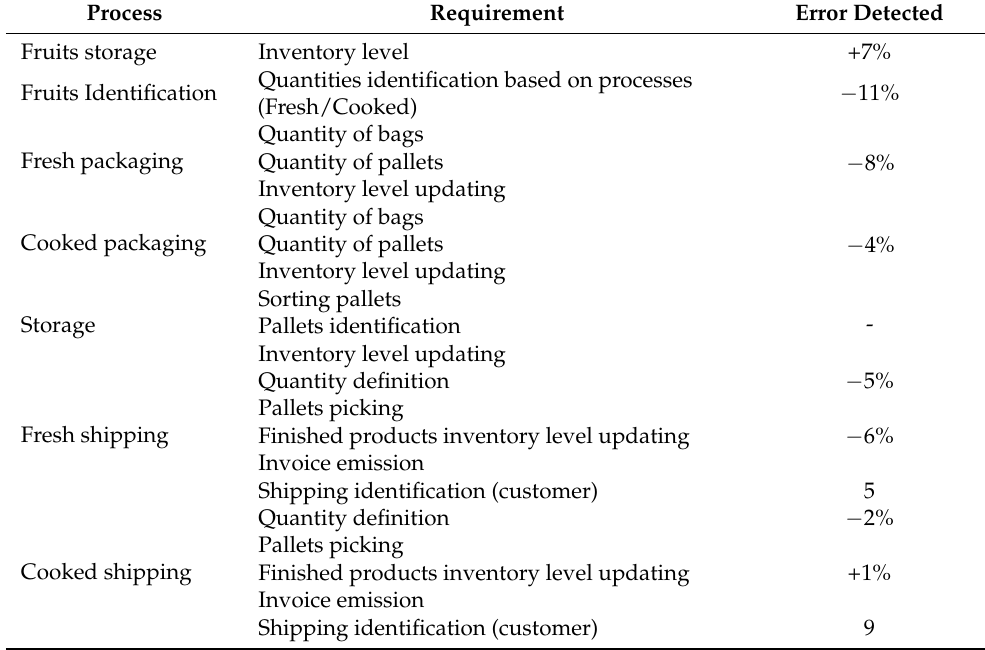
Table 5. Process requirements